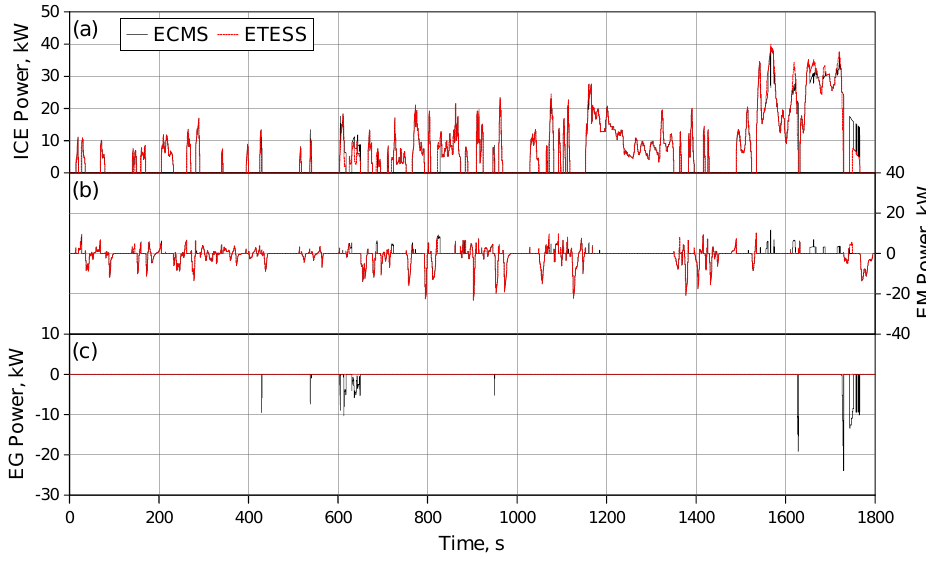
Figure 7. Power (kW) comparison between ETESS and ECMS: ( a ) ICE; ( b ) EM; ( c ) EG.